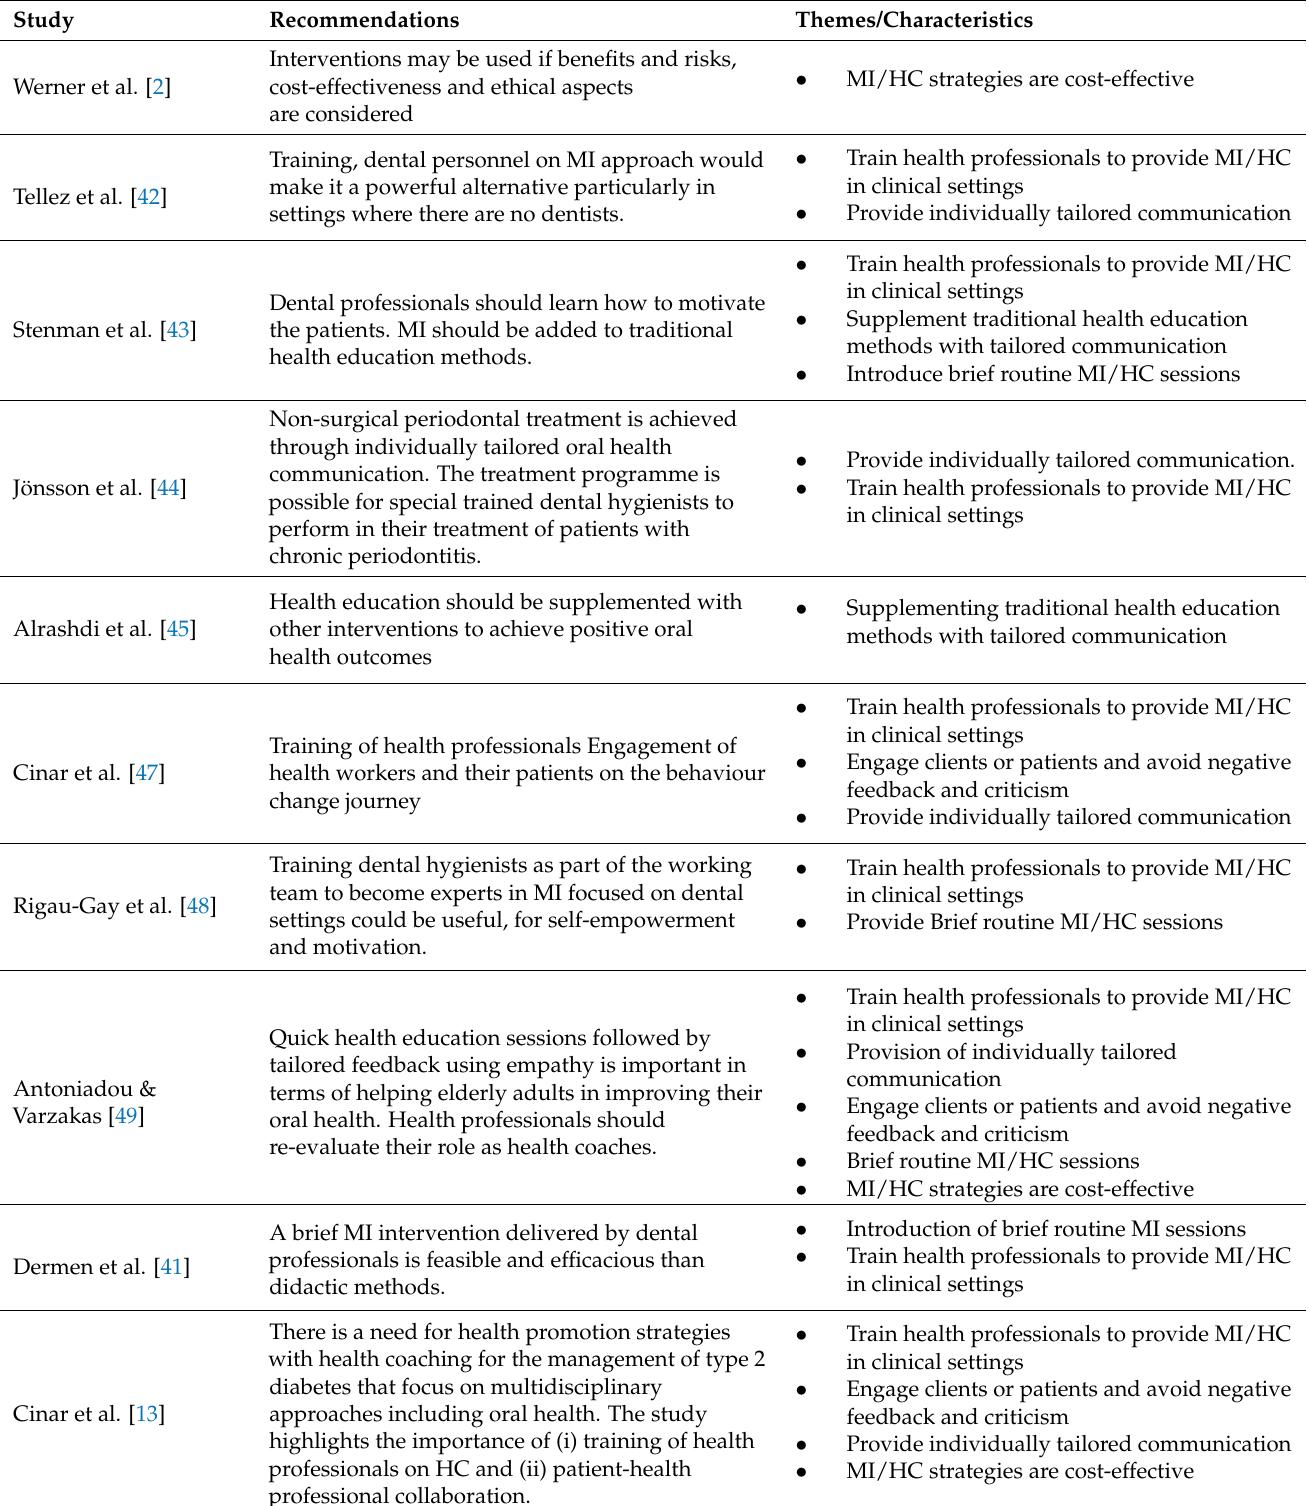
Table 5. Extracted recommendations and identified